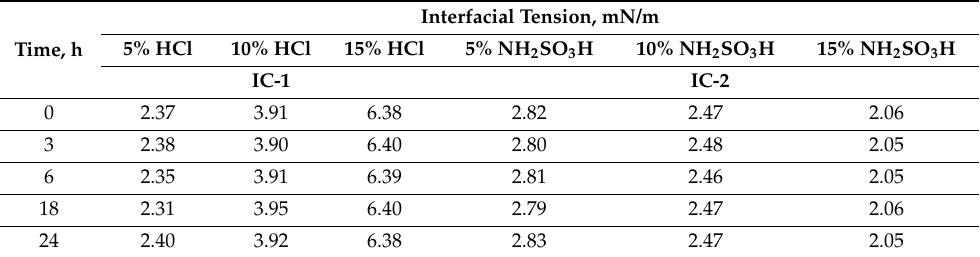
Table 3. The values of the interfacial tension index of solutions of hydrochloric and sulfamic acids with the addition of corrosion inhibitors at the border with n-octane.